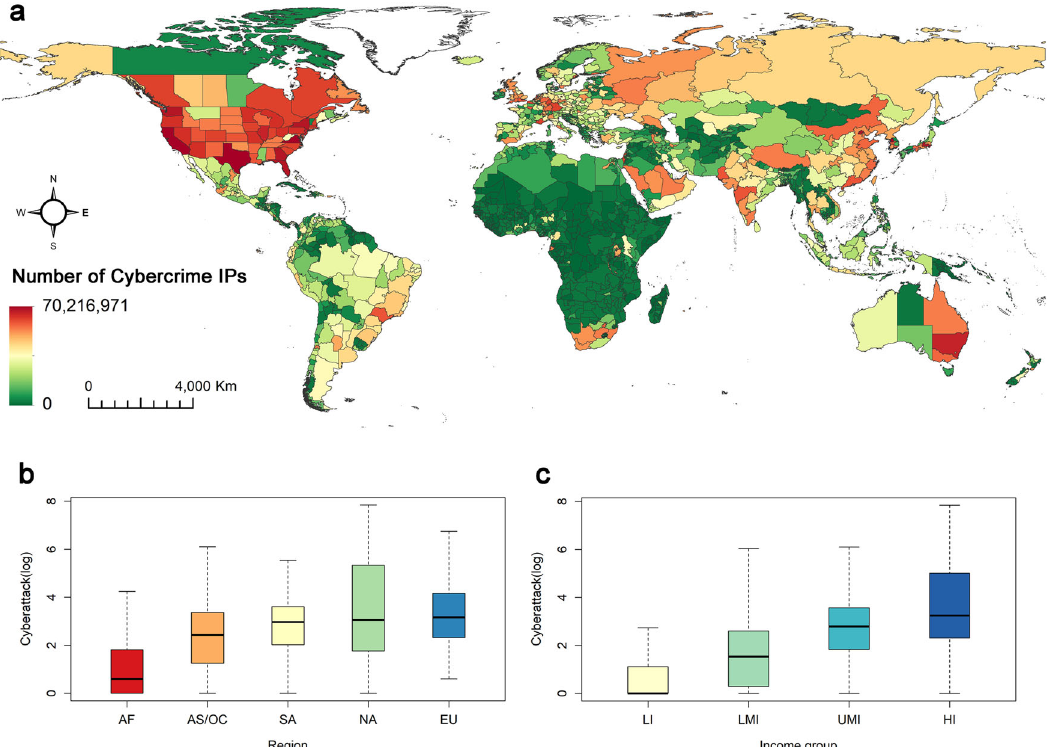
Fig. 2 Global distribution of cybercrime IPs. a Number of cybercrime IPs at the subnational level. b Log-transformed cybercrime IP count by continent: Africa (AF), Asia/Oceania (AS/OC), South America (SA), North America (NA) and Europe (EU). c Log-transformed cybercrime IP count by income group: low-income (LI), lower-middle-income (LMI), upper-middle-income (UMI) and high-income (HI) groups. The centre line, boxes, and whiskers show the means, 1 standard error (SE), and 95% con fi dence interval (CI),